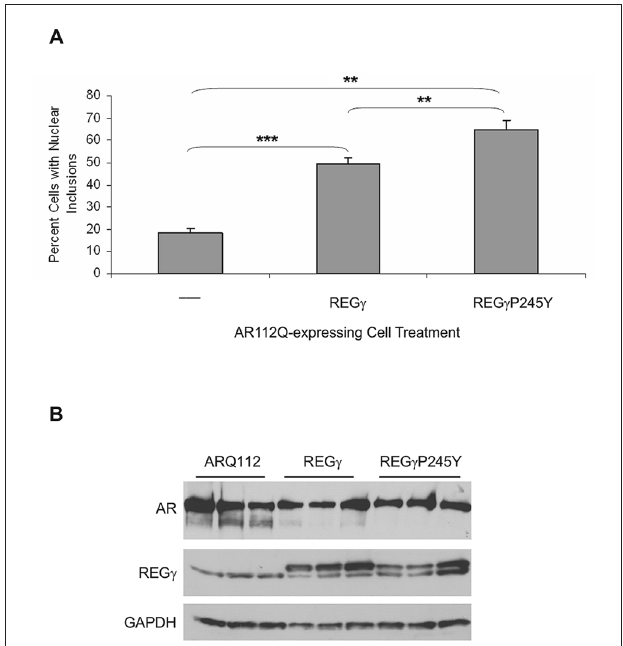
FIGURE 3 | Overexpression of REG γ P245Y mutant significantly increases the percentage of cells with ARQ112 nuclear inclusion bodies. PC12 ARQ112 cells that stably overexpress either REG γ or REG γ P245Y were induced with Dox and treated with DHT for 72 h. (A) Cells were immunostained with AR(H280) and stained with Hoechst. The number of cells containing nuclear inclusions was determined and their percentage calculated. Single factor ANOVA with post hoc Bonferroni-corrected t -test was performed. ∗∗ p < 0.01; ∗∗∗ p < 0.001. See Supplementary Figure S1 for additional analysis of AR aggregation. (B) Western blot analysis of same cell populations as in (A) reveals lack of effect of REG γ or REG γ P245Y overexpression on monomeric AR levels.